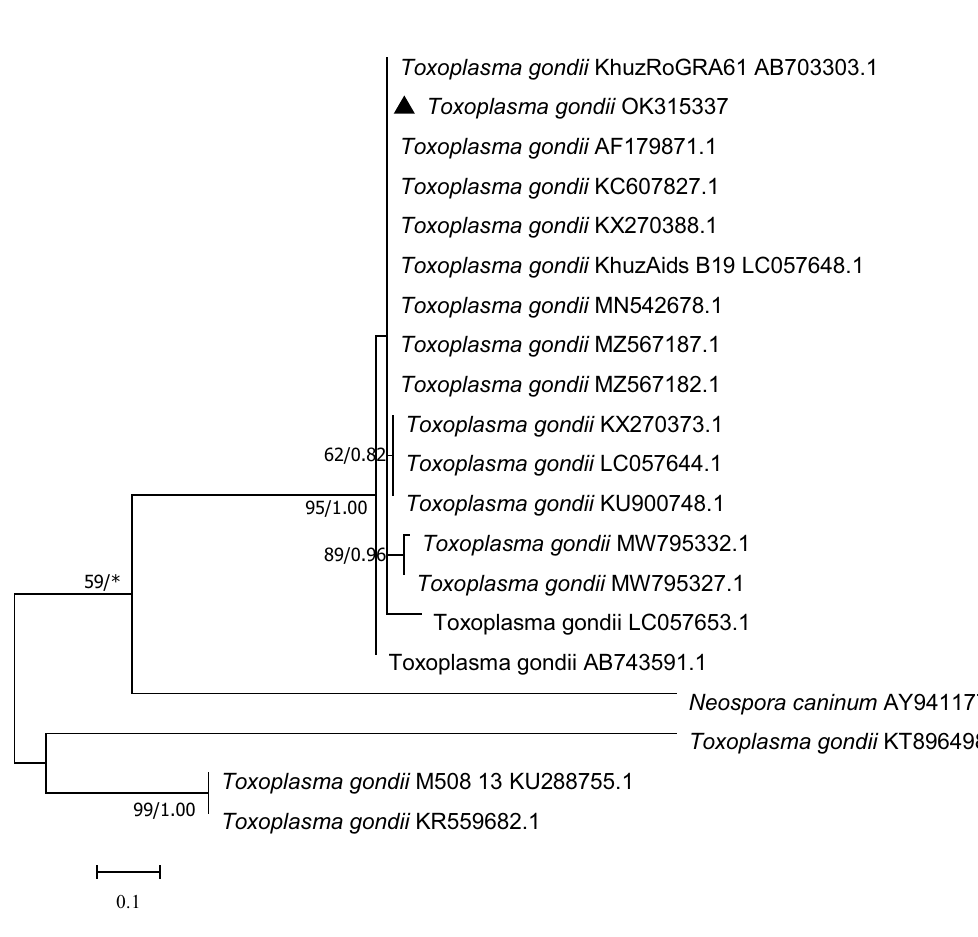
Figure 2. Phylogenetic tree based on the B1 gene of T. gondii isolates from naturally infected equids and those previously deposited in the GenBank database. The ML tree and Bayesian inference were implemented by MEGA7 with a Kimura-2-parameter model and MrBayes3.2 with the HKY + I model, respectively. ML Bootstrap values < 50 and BI posterior probabilities < 0.80 were not shown. The gene sequence marked with triangle was obtained in this